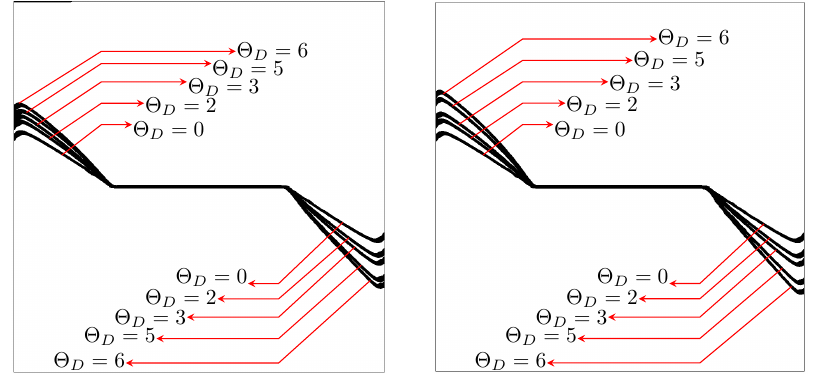
Figure 18. Comparison of the crack paths using TF-PFM1 ( left ) and TF-PFM2 ( right ) with the given temperature variations under Mode I + II at the final computational